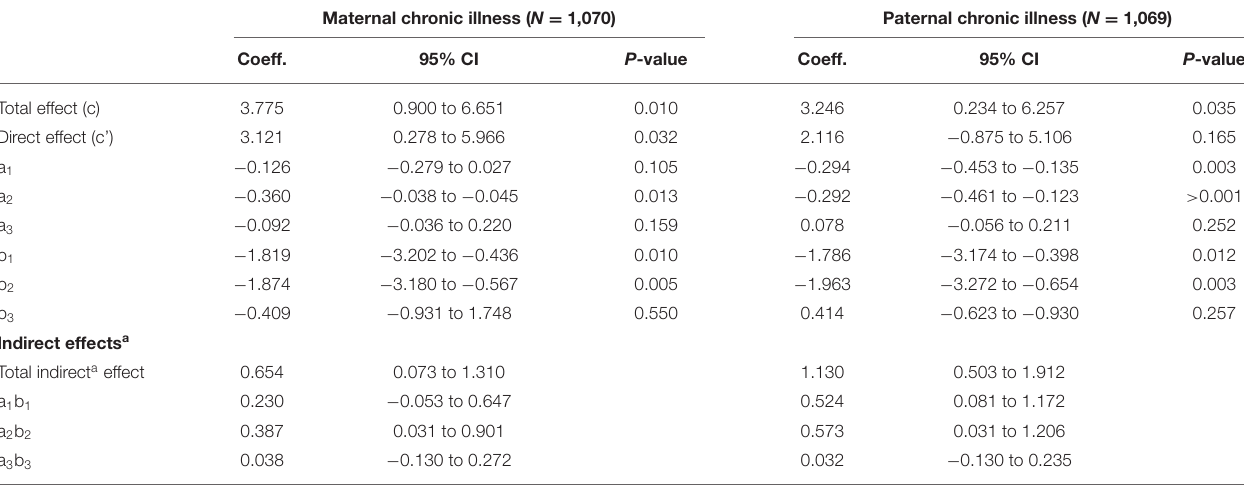
TABLE 3 | Path coefficients for the parallel mediation models and separate models for maternal and paternal chronic illness. Maternal chronic illness ( N = 1,070)